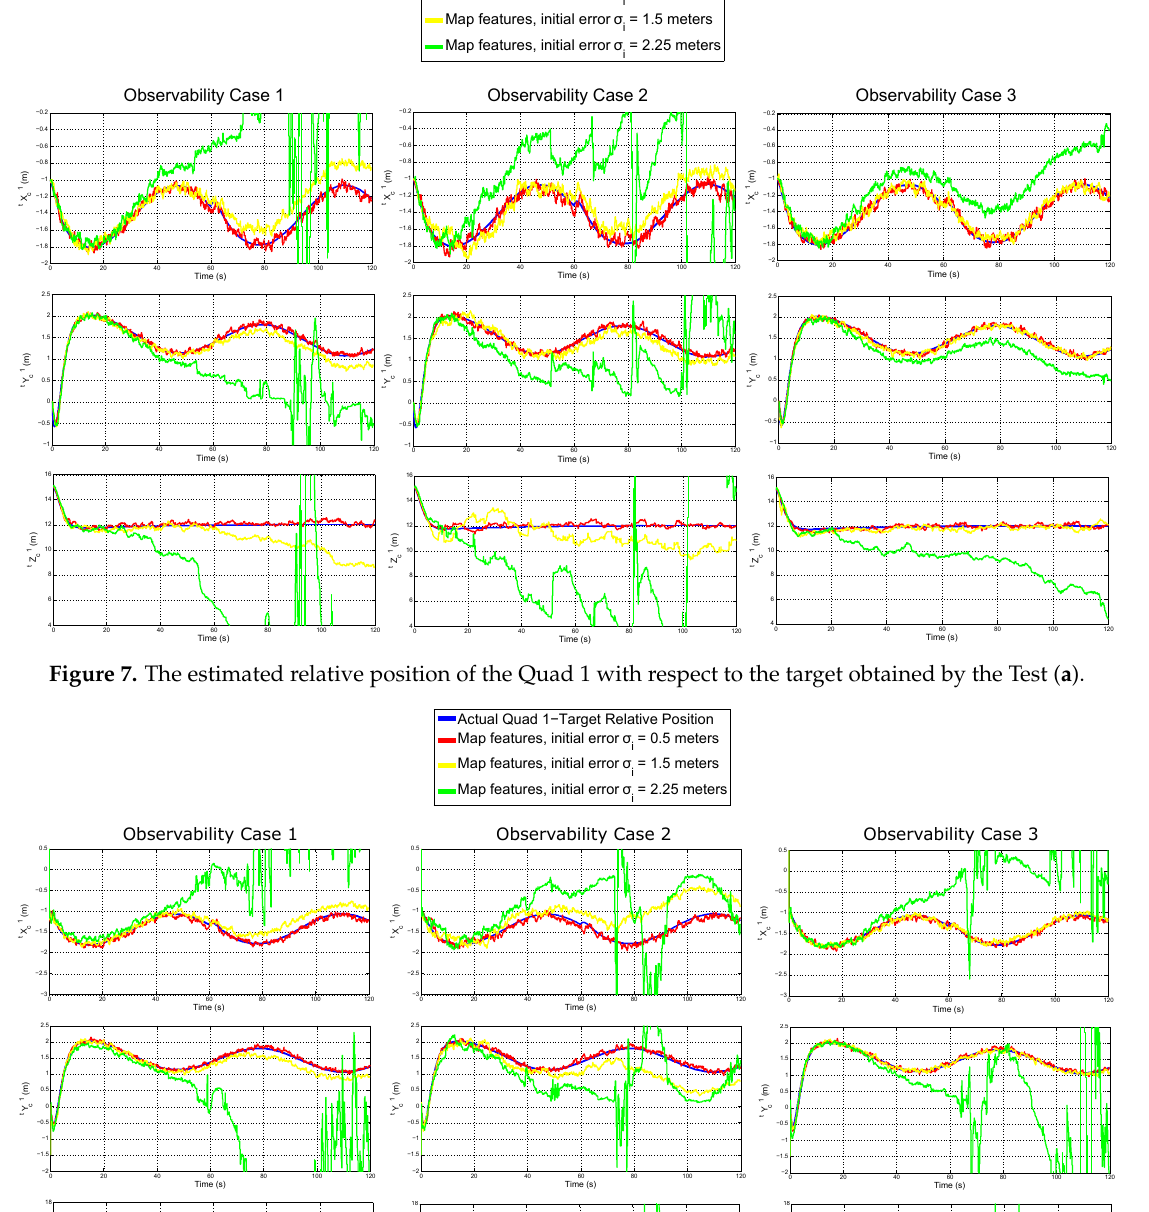
Actual Quad 1−Target Relative Position Map features, initial errorσ i = 0.5 meters Map features, initial errorσ i = 1.5 meters